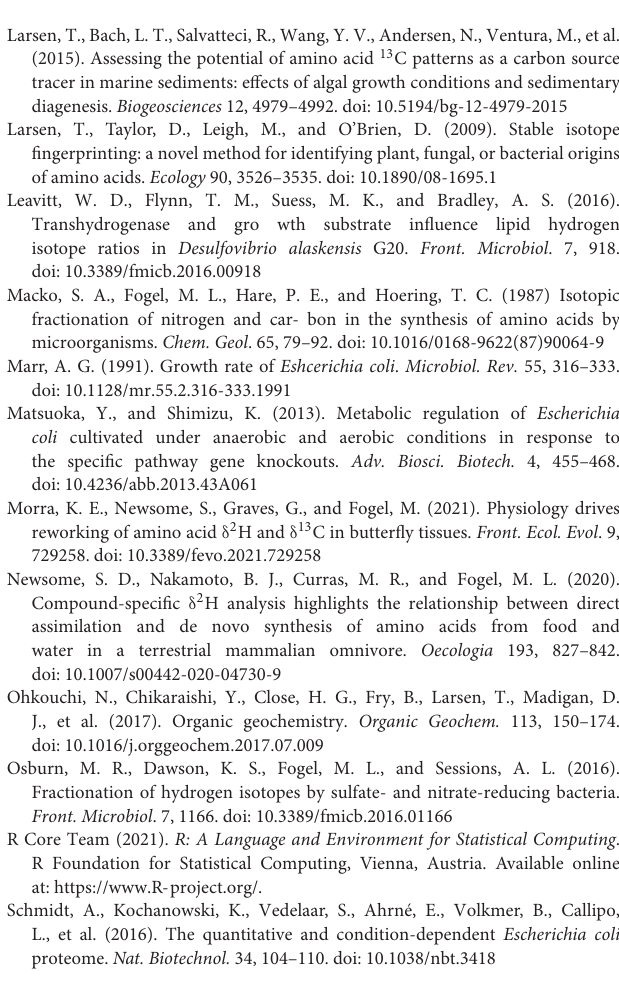
Supplementary Table 1 | Carbon and hydrogen isotope values of amino acids. Supplementary Table 2 | The biosynthetic pathways, substrates and enzymes for amino acids in